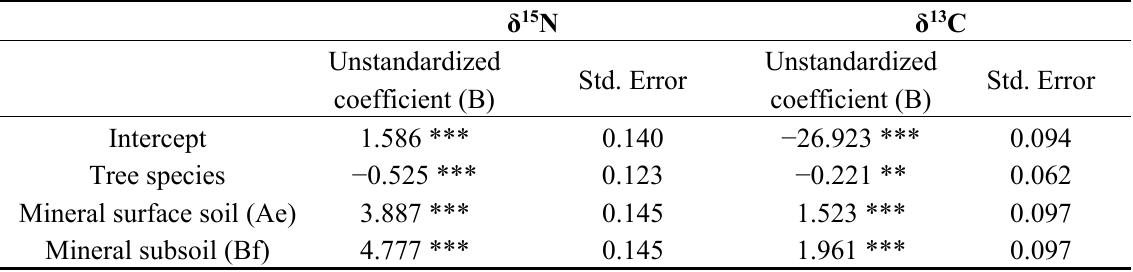
Table 2. Linear regression (OLS) coefficients with standard error for the regression model predicting δ 15 N (F = 314.044, p < 0.001, R 2 = 0.932) and δ 13 C (F = 117.897, p < 0.001, R 2 = 0.838) of soil based on tree species, and Ae and Bf soil horizons.